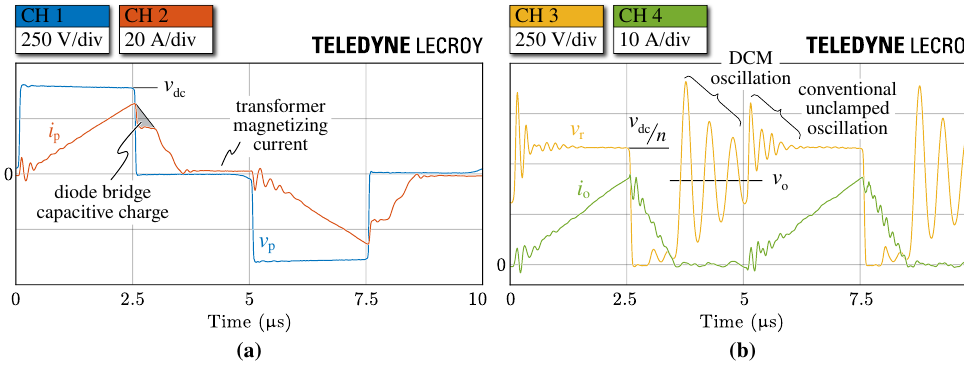
Figure 18. Experimental PSFB waveforms at V b = 400V and I b = 6A: ( a ) primary transformer voltage ( v p ) and current ( i p ) and ( b ) secondary rectified voltage ( v r ) and output current ( i o ).